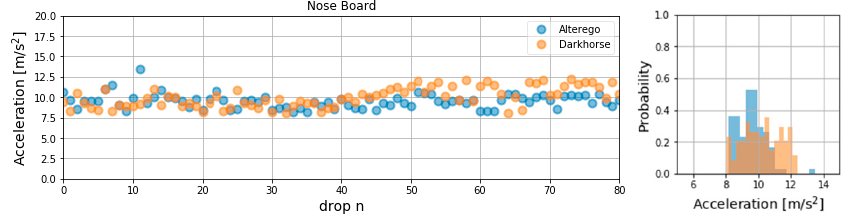
Figure 4. Accelerations measured on the board from weight drop test. ( Left ) Peak values for each hit. ( Right ) histogram of the values.